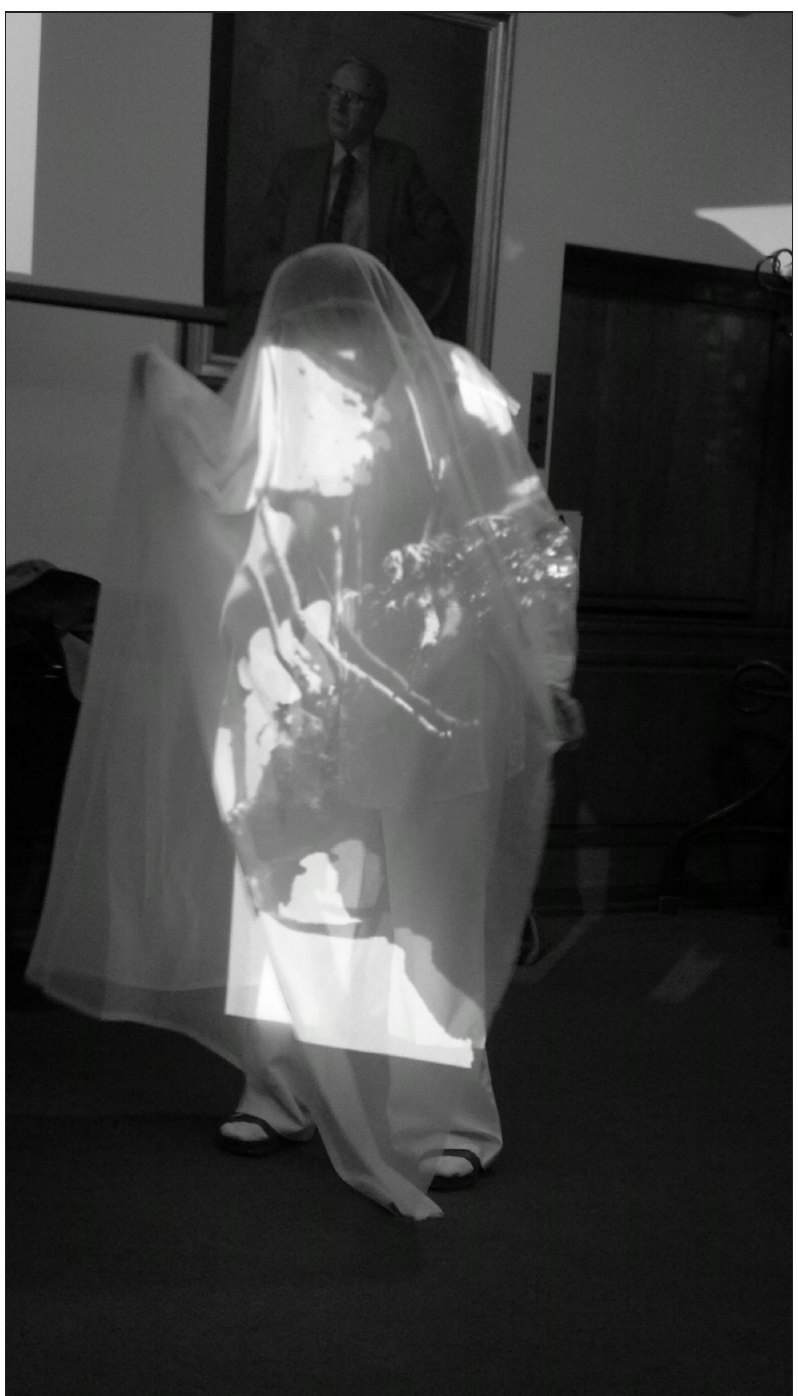
Figure 3.3: Jennifer Pike at Birkbeck College, University of London, 2011. Courtesy of